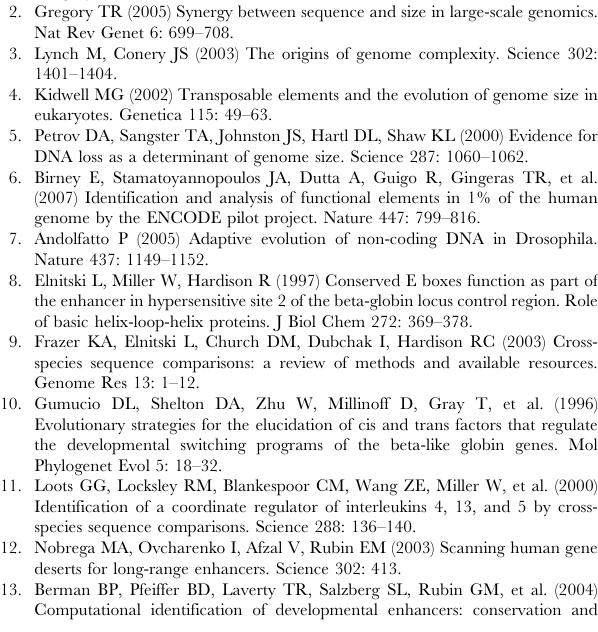
Table S3 Intergenic regions ( . 2,000 bp) with conserved blocks between 500 and 2,000 bp flanked by non-conserved blocks of